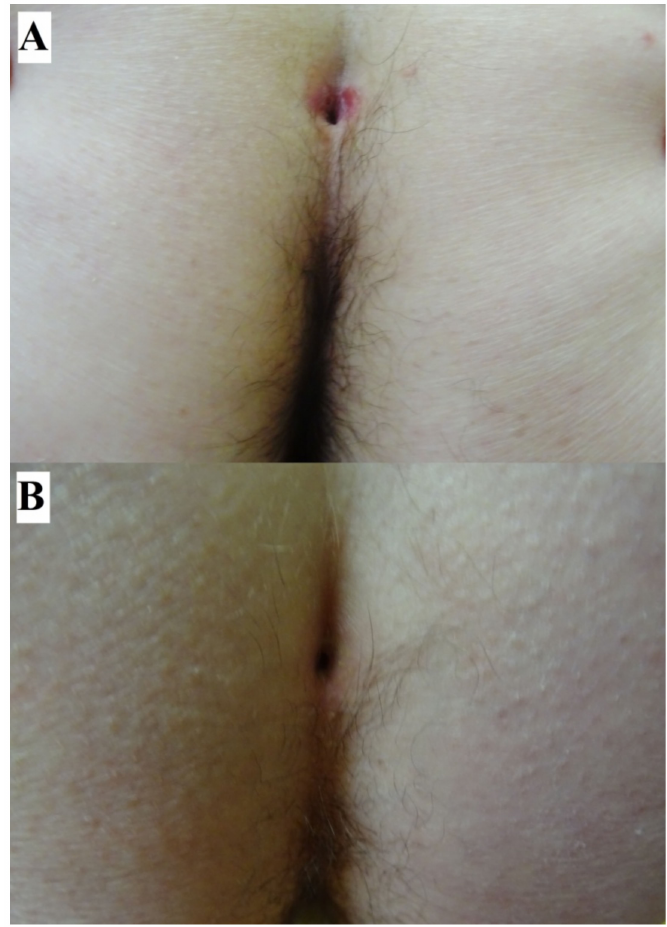
Figure 1. A 48-year-old woman with PV affecting the sacral dimple ( A ). Healing of lesions around the sacral dimple after implementing treatment for pemphigus ( B